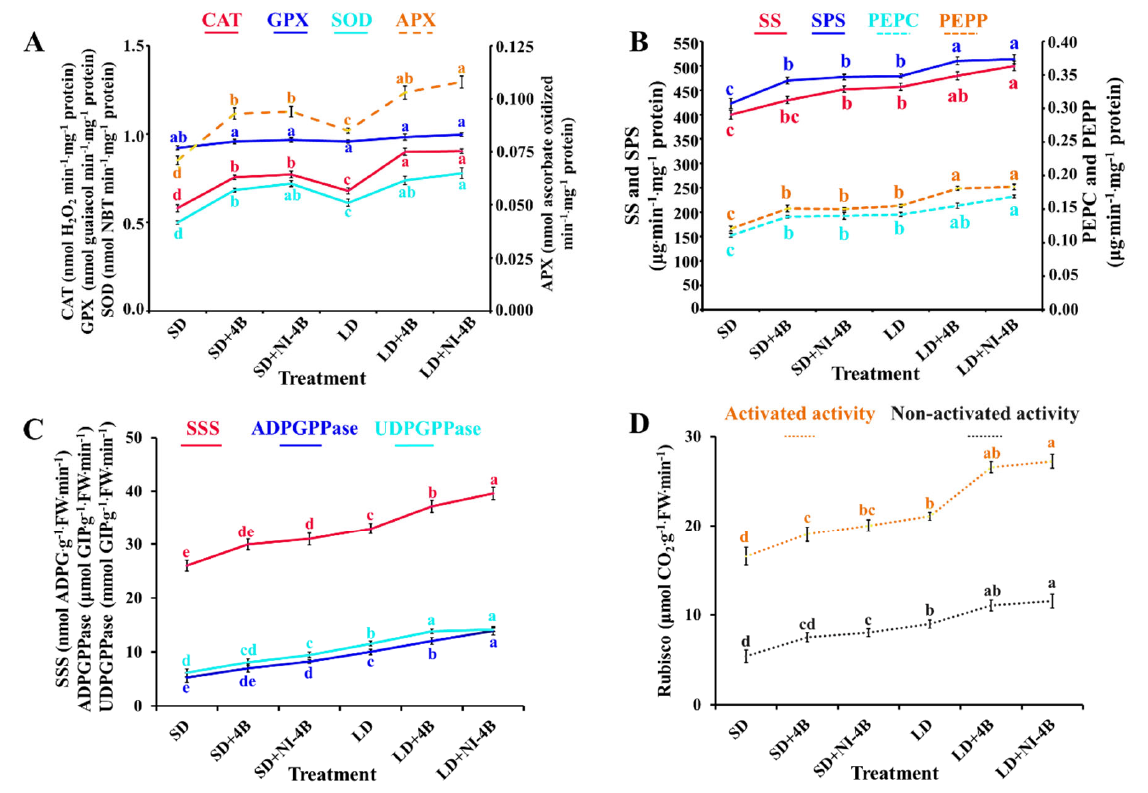
Figure 8. The effects of the supplementary and night-interrupting 10 µ mol · m − 2 · s − 1 PPFD B light on the enzymatic activities in kalanchoe ( Kalanchoe blossfeldiana ‘Rudak’), after 60 days of exposure to the photoperiodic light treatments: the reactive oxygen species (ROS) scavenging enzymatic activities ( A ): catalase (CAT), guaiacol peroxidase (GPX), superoxide peroxidase (SOD), and ascorbate peroxidase (APX); sucrose synthesis enzymatic activities; ( B ): sucrose synthase (SS), sucrose phosphate synthase (SPS), phosphoenolpyruvate carboxykinase (PEPC), and phosphoenolpyruvate phosphatase (PEPP); starch synthesis enzymatic activities; ( C ): soluble starch synthase (SSS), adenosine diphosphate glucose pyro-phosphorylase (ADPGPPase), uridine diphosphate glucose pyro-phosphorylase (UDGPPase); photosynthesis enzymatic activities; ( D ): activated and non-activated activity of RuBisCo. Vertical bars indicate the means ± standard error ( n = 6). Different lowercase letters indicate significant separation within treatments by the Duncan’s multiple range test at p ≤ 0.05. (See Figure 2 for details on the photoperiodic treatments with B light).